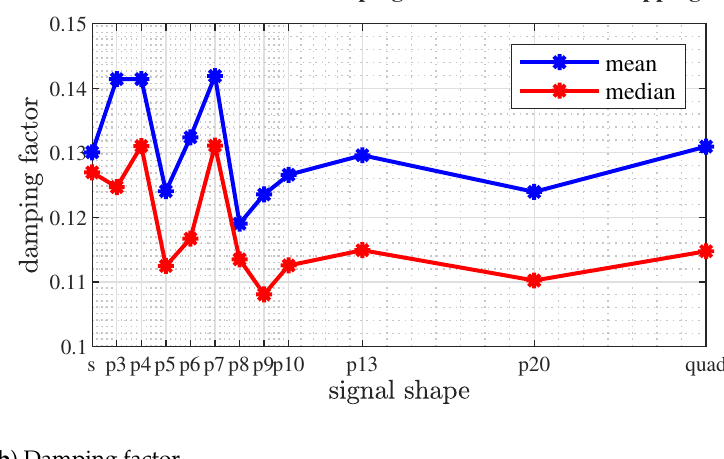
Figure 21. Medium and median values of estimated parameters for selected microsptepping signals at x16 resolution.